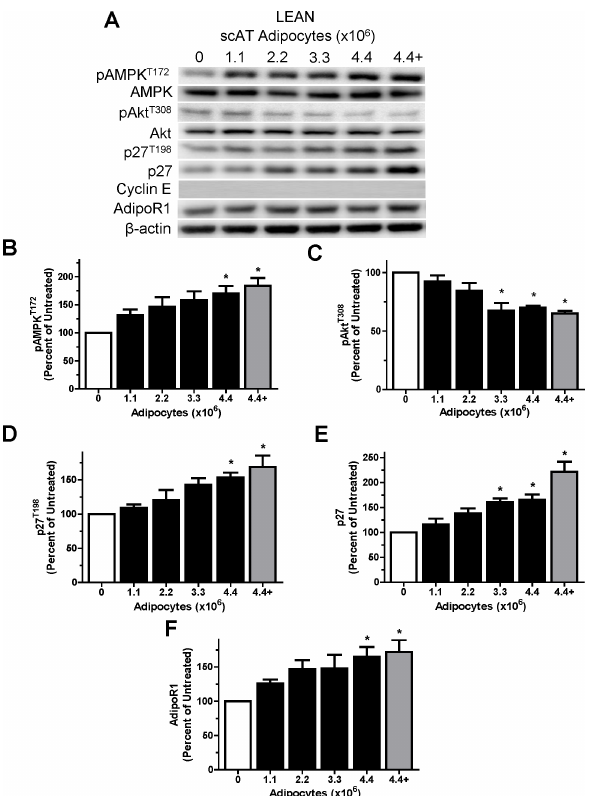
Fig 2. Lean Zucker subcutaneous adipocytes co-culture positively affectsMCF7 cell cycle proteins in does-dependent manner. A: Representative western blots for selectedproteinsshowingthe effects of treatment with UT (open bar) or lean Zucker scAT increasingadipocytenumber(closed bars) or the highest adipocytenumber(4.4 × 10 6 ) plus ADIPO (18 nM; grey bar) co-culture treatment for 24 hours in arrested MCF7 cells. B-F: Graphicalrepresentations of multipleexperiments showingthe effects of lean Zucker scAT increasing adipocytenumber and the additionof ADIPO (9 nM) on pAMPK T172 , pAKT T308 , p27, p27 T198 and AdipoR1protein levels. β -actin was used as a loadingcontrol. One-way ANOVAs showedsignificantmain effects for all experiments (p < 0.05). * denotessignificantly different from ZDF (p < 0.05)as determined by Tukey’s post-hoc tests (n =